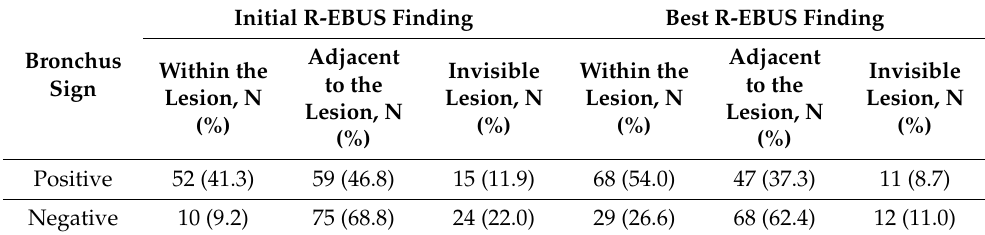
Table 5. Relationship between bronchus sign and R-EBUS findings.